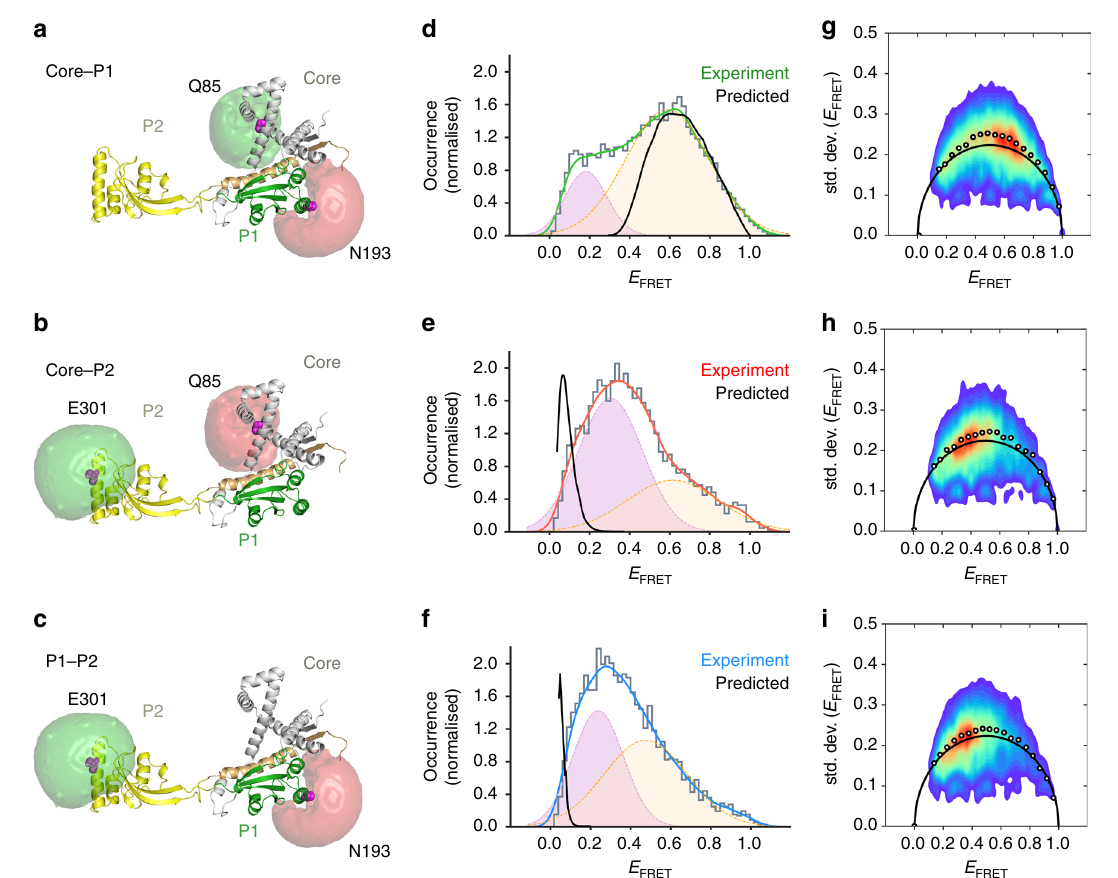
Fig. 3 Comparison of smFRET data to values predicted from crystal structure of SurA. The crystal structure of SurA indicating the available volumes calculated for each dye label at residues a 85 and 193 (core-P1 distance probes); b 85 and 301 (core-P2 distance probes) and c 193 and 301 (P1-P2 distance probes). d – f Predicted E FRET between each pair of dyes for the crystal structure of SurA (black line) and the observed E FRET distributions (green, red or blue lines) independently fi tted to two Gaussians (pink/yellow). g – i BVA reveals high variance for all three dye pairs. The average values of the measured variance for the E FRET values (white fi lled circles) lie above the expected shot-noise limited standard deviation (black arc) indicating dynamics on a timescale faster than the duration of the bursts (here sub-ms). Predicted E FRET distributions d – f were calculated from the SurA crystal structure (PDB 1M5Y 27 ) using distance distributions generated by the MtsslWizard plugin for PyMOL 103 , which takes into account both the location of the dyes and the fl exibility of the dye linkers 39 . Note that all dyes can be considered as freely rotating, as manifested by their low anisotropy (Supplementary Table 2), hence changes in E FRET can be translated to distance variations. Samples contained ~50 pM labelled SurA variant in 50 mM Tris-HCl, pH 8.0, 25